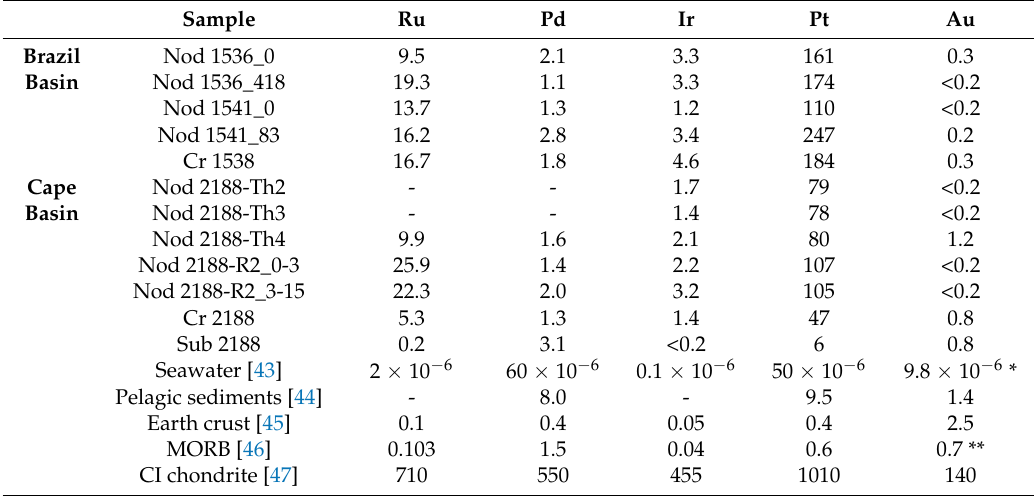
Table 4. PGE content (ng/g) in ferromanganese crust and nodules from the Cape and Brazil Basins. Sample